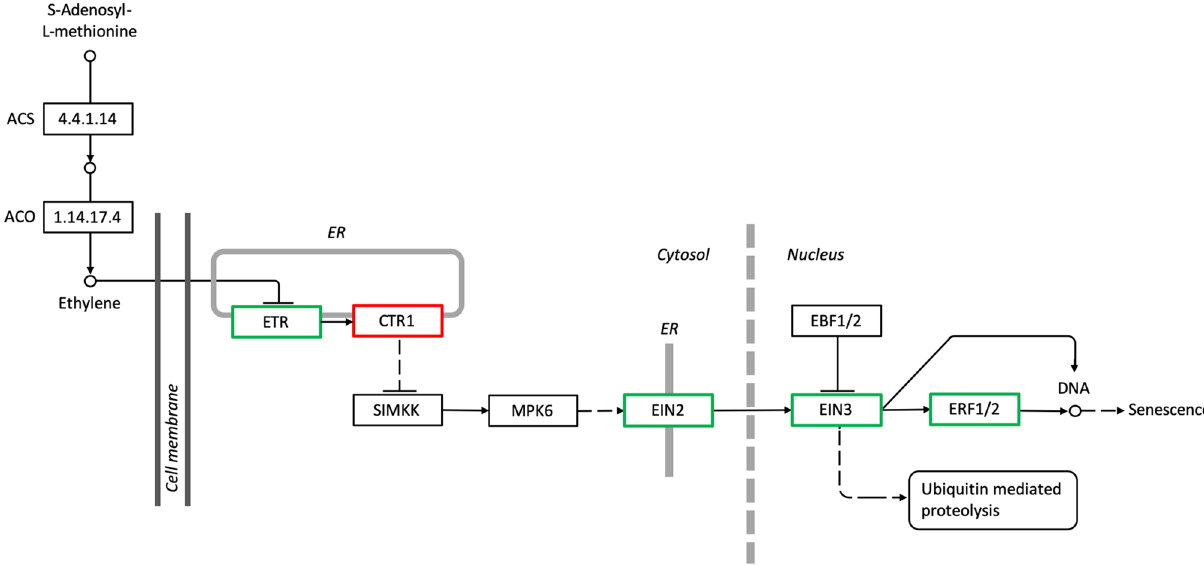
Figure 4. KEGG pathway of ethylene biosynthesis and signal transduction pathway mapped with Rafflesia cantleyi unigenes. Green outlined boxes represent up-regulated unigenes while the red outlined box represents a down-regulated unigene. ER endoplasmic reticulum; ACO 1-AMINOCYCLOPROPANE-1-CARBOXYLATE OXIDASE ; ACS 1-AMINOCYCLOPROPANE-1-CARBOXYLATE SYNTHASE ; CTR1 CONSTITUTIVE TRIPLE RESPONSE 1 ; EBF1/2 EIN3-BINDING F-BOX PROTEIN ; EIN2 ETHYLENE-INSENSITIVE 2 ; EIN3 ETHYLENE-INSENSITIVE 3 ; ERF1/2 ETHYLENE-RESPONSIVE TRANSCRIPTION FACTOR 1/2 ;